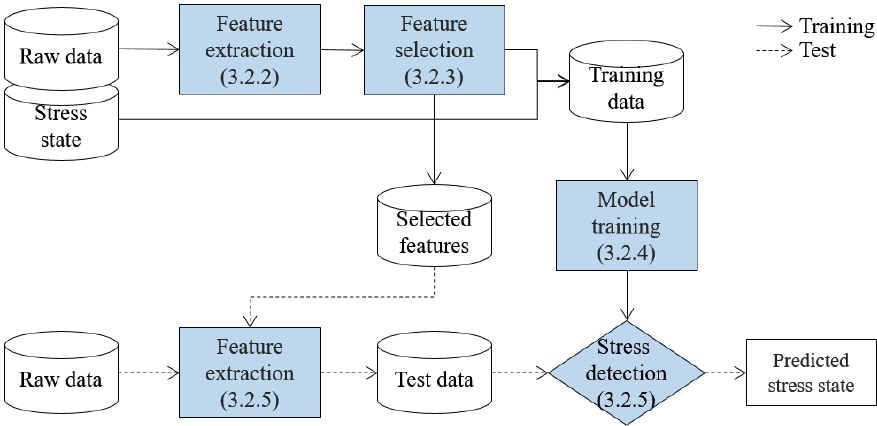
Figure 2. Overview of the learning-based stress detection